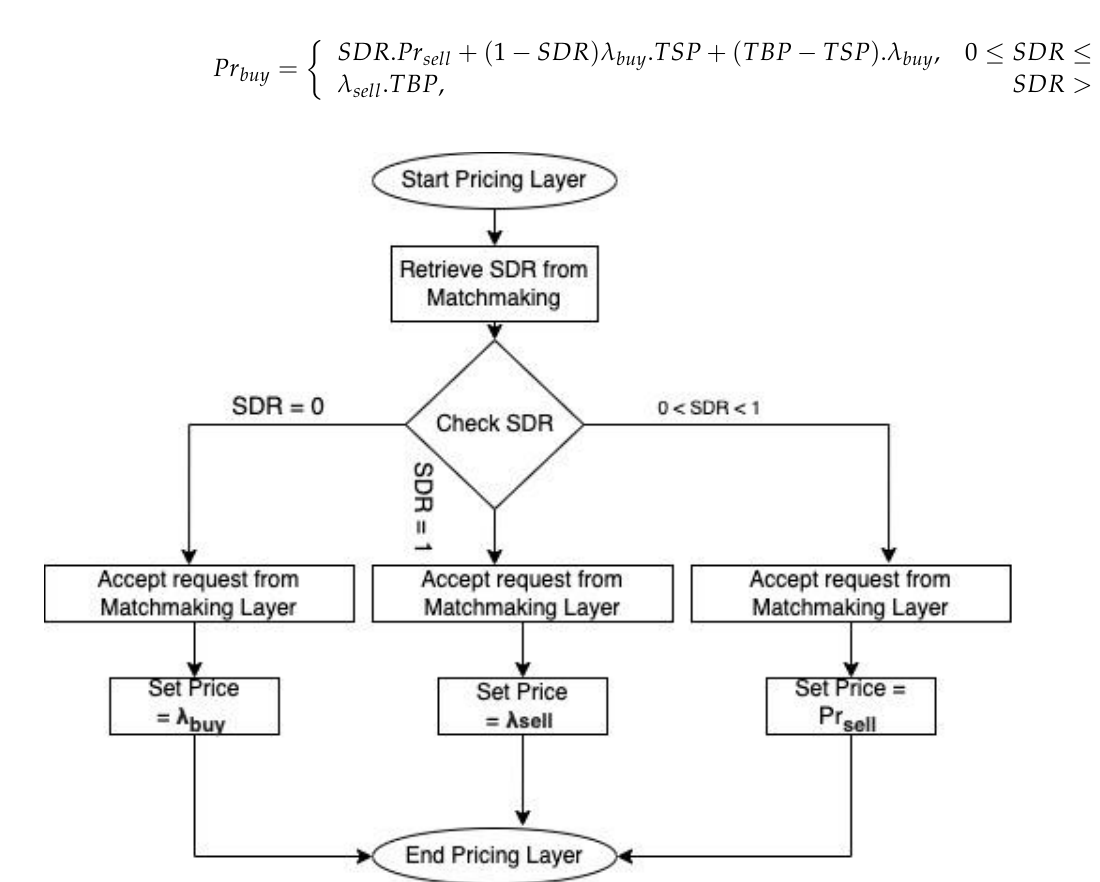
Figure 6. Pricing layer for different SDR ratios .